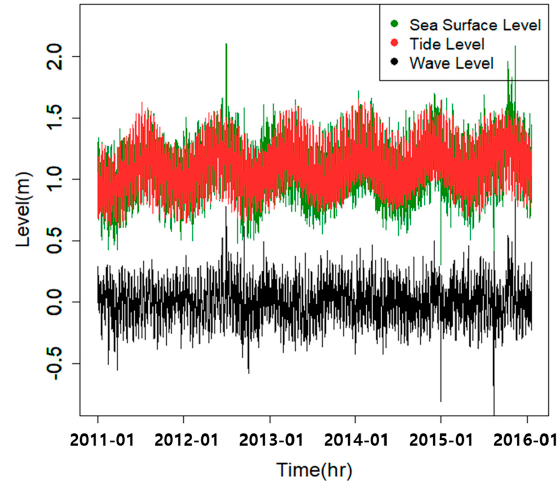
Figure 7. Wave component at Ulsan station.